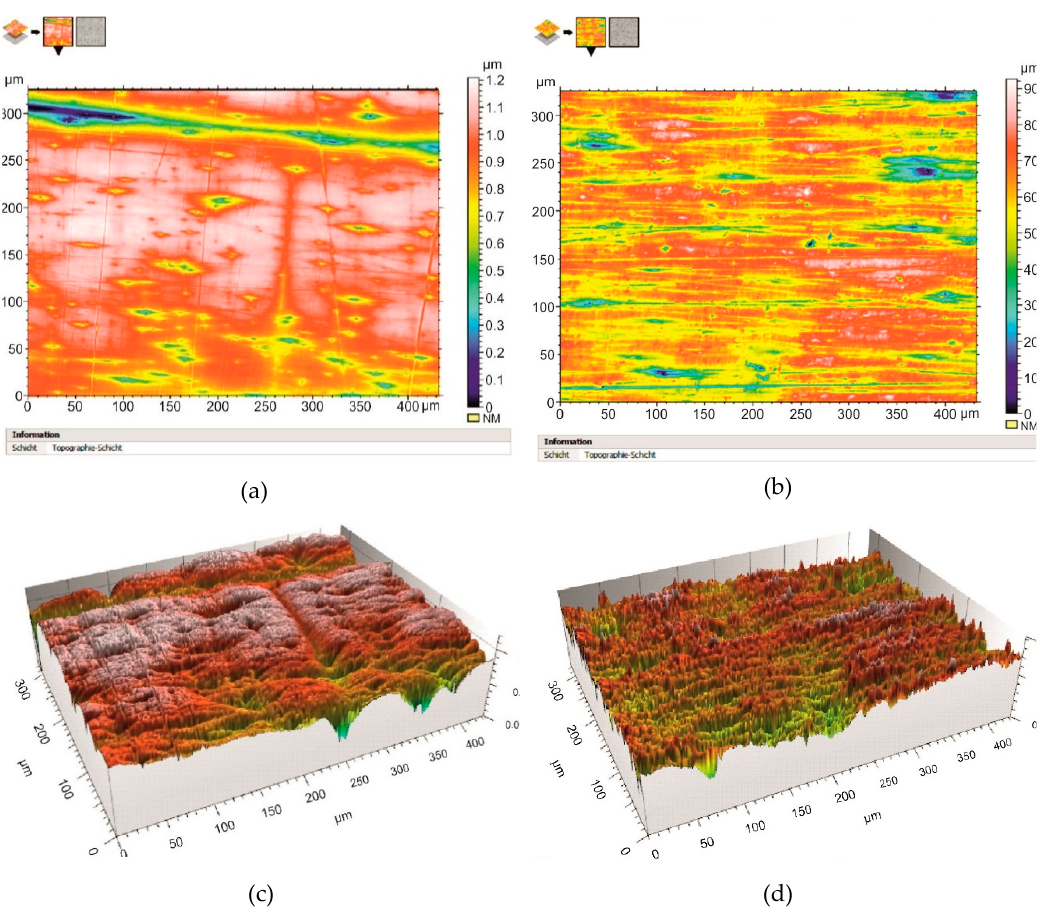
Figure 4. Topographies of plane surfaces of samples of the VT23 alloy in the initial state ( a , c ) and after DNP( ε imp = 0.85%) ( b , d ): ( a , b ), 2D measurements; ( c , d ), 3D measurements.